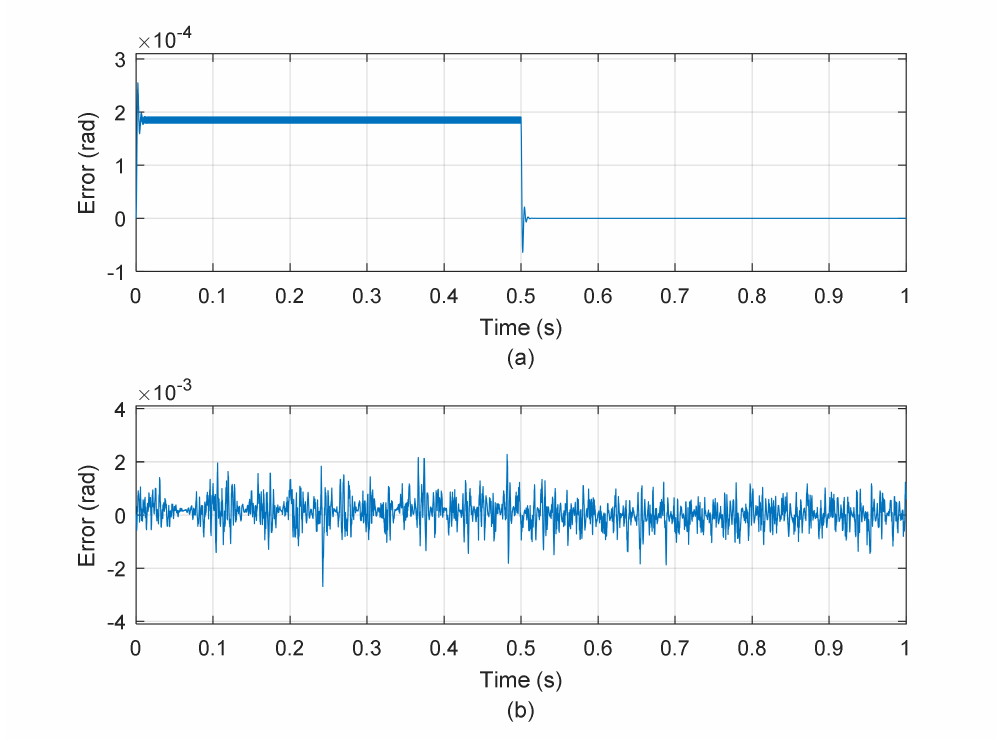
Figure 13. Simulation results for the PI-based ATO. ( a ) Without noise; ( b ) with noise. Table 3 shows the root mean squared error (RMSE) and the error settling time (the time required for the error signal to achieve its steady-state value) for each